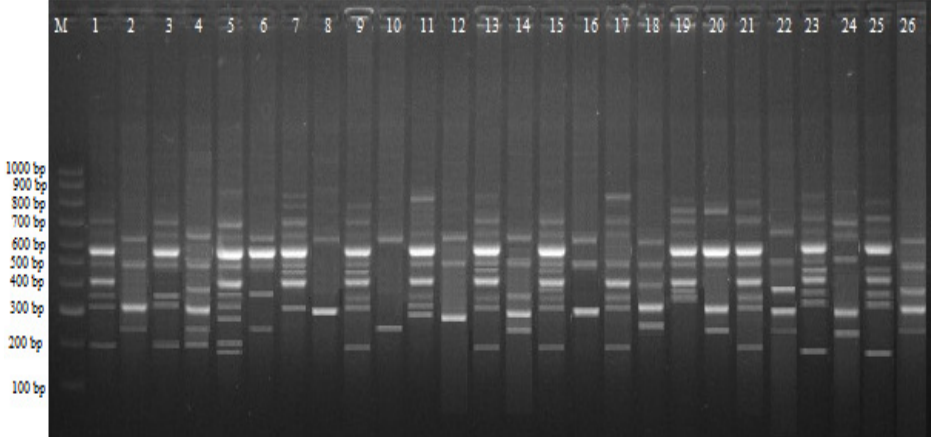
Figure 2. CRED-iPBS profiles for various experimental groups with iPBS 2391 primers in wheat. M,